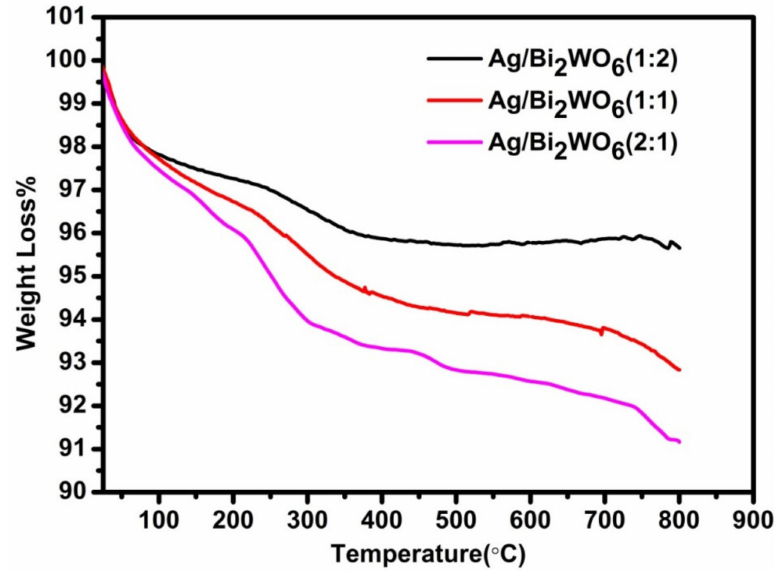
Figure 7. TGA spectra of Ag/Bi 2 WO 6 (1:1, 1:2 and 2:1).